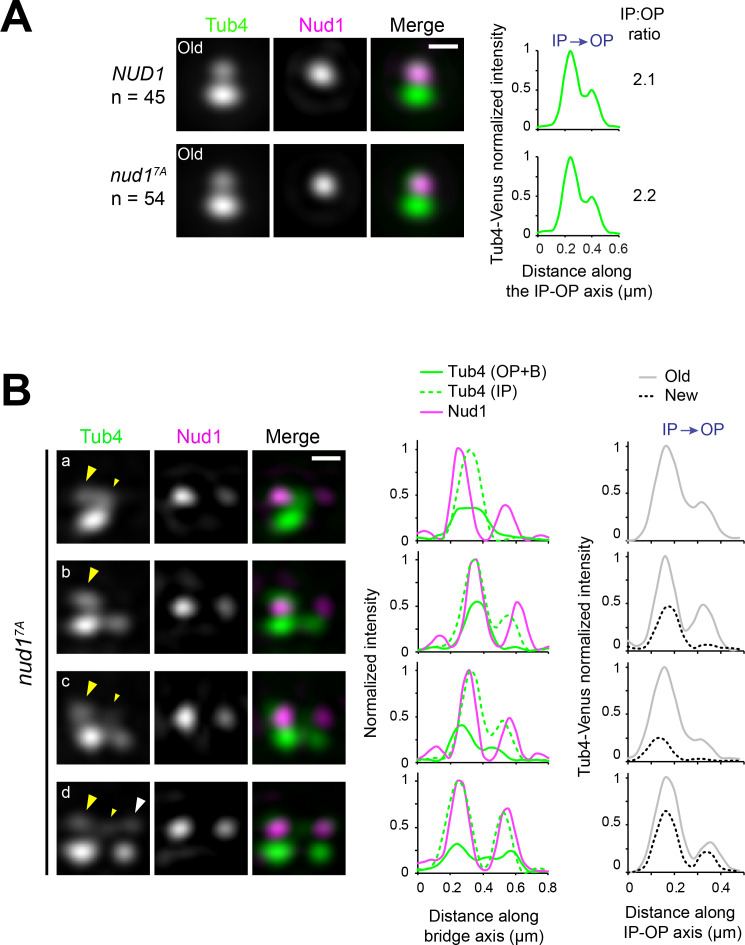
Nud17A anticipates Spc72 recruitment without otherwise affecting the Tub4 IP:OP ratio.(A) Tub4 IP:OP ratio in SPBs of NUD1 versus nud17A cells carrying short spindles (<2.5 µm-long). SIM averaged images of old SPBs obtained after 3D-Gaussian fitting and realignment using Tub4-Venus as reference. Scale bar, 200 nm. The number of SPBs is indicated. Linescan analysis for Tub4-Venus intensity along the IP-OP axis is shown. (B) Representative images of unseparated SPBs in asynchronous nud17A cells following 3D-Gaussian fitting and realignment using Nud17A-CFP as reference. Tub4-Venus distributed between the old SPB and bridge during duplication (a-c; big and small yellow arrowheads, respectively) but was prematurely added to the new SPB outer plaque at the side-by-side stage (after a Tub4 focus was established at the new inner plaque) without otherwise perturbing the IP:OP ratio (d).